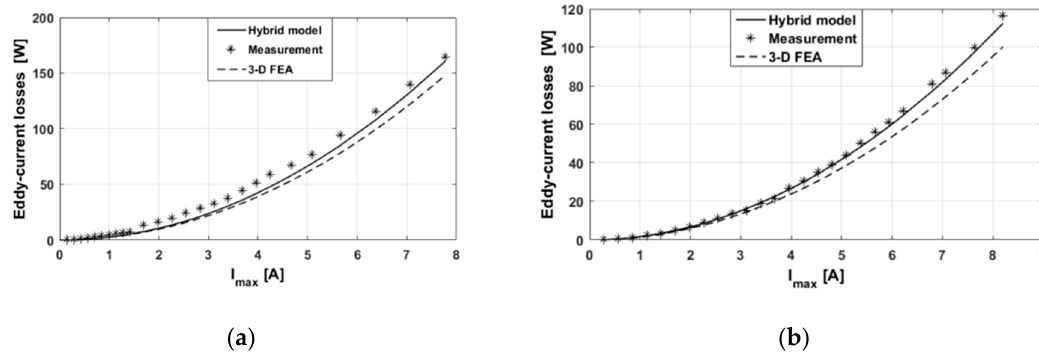
Figure 17. Validation of eddy-current losses (analytical, numerical, and experimental) in massive conductive parts versus I max with M l s (cid:44) L l s (cid:44) R l s for: ( a ) h mp = 6mm and ( b ) h mp = 10mm.